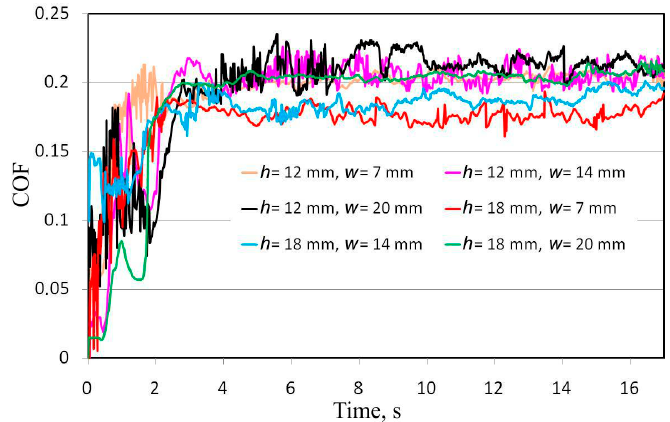
Figure 6. Experimentally determined variation of the coefficient of friction during a drawbead test.